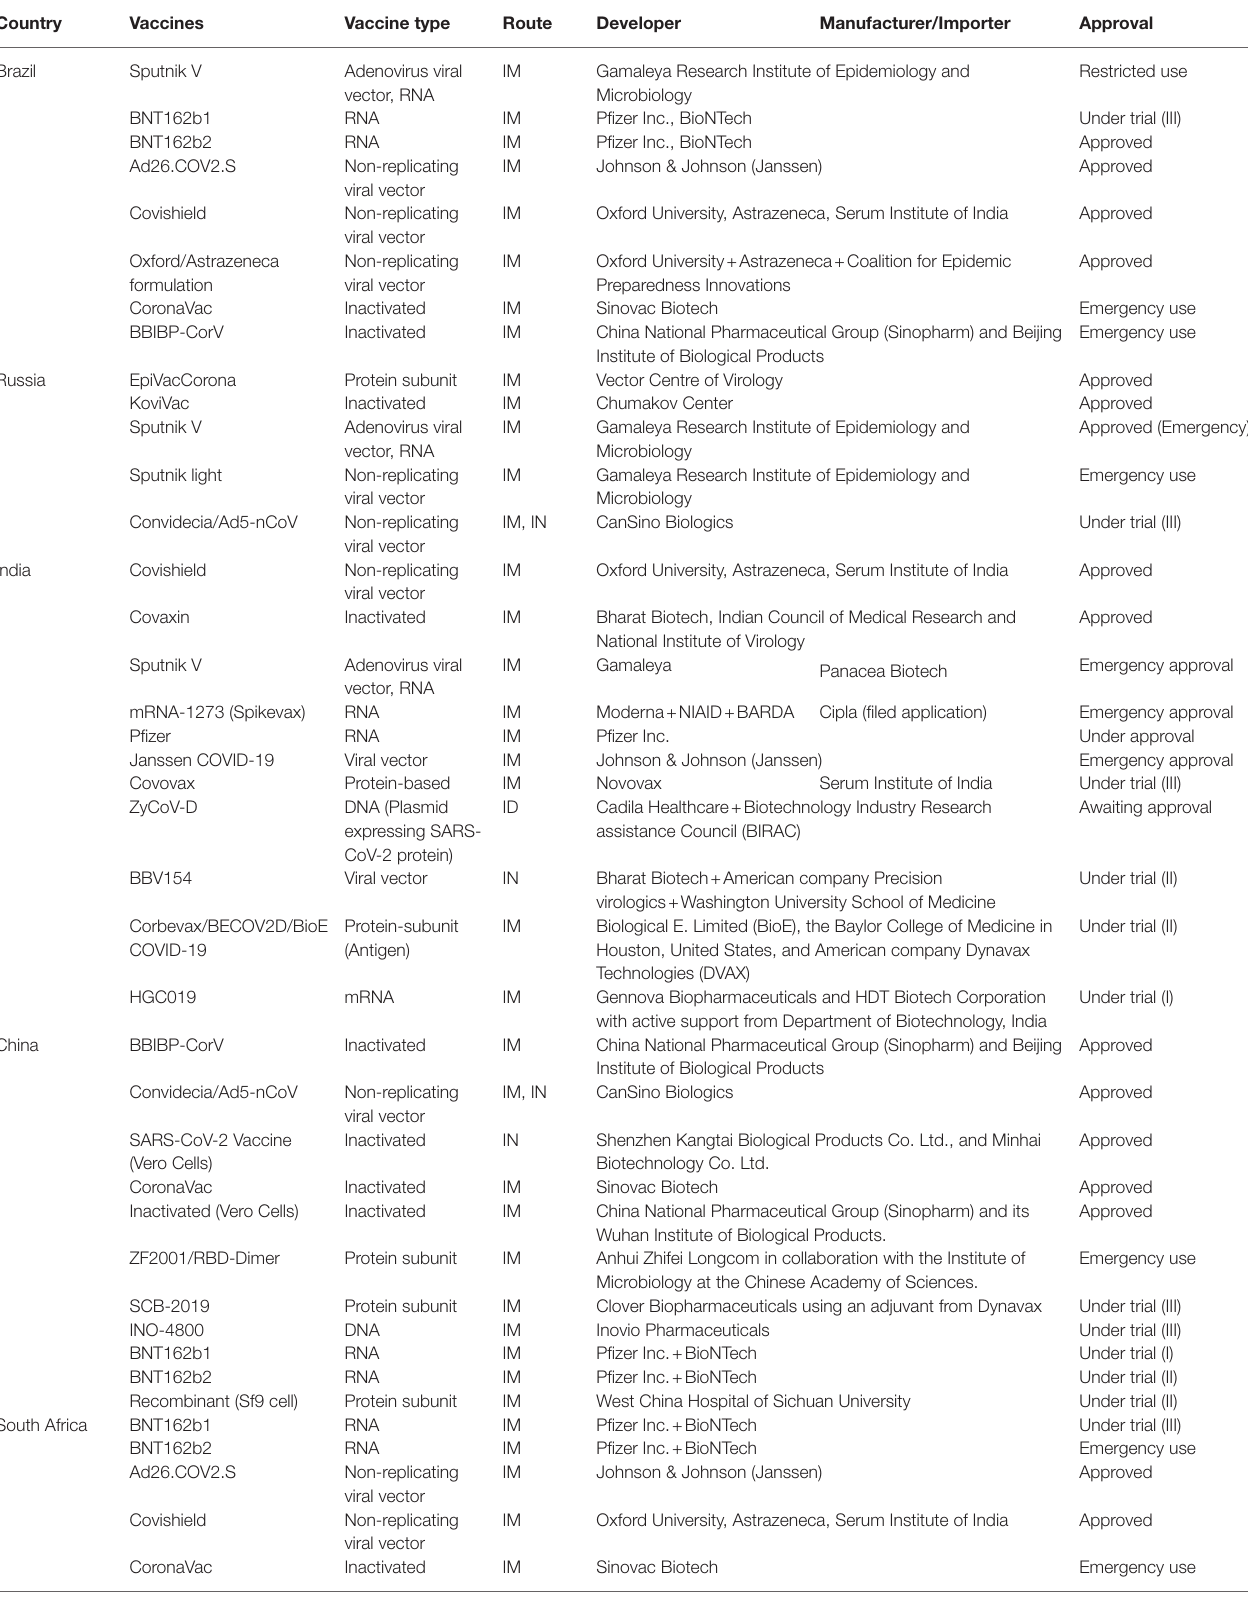
TABLE 1 | COVID-19 vaccine being used in BRICS nations.